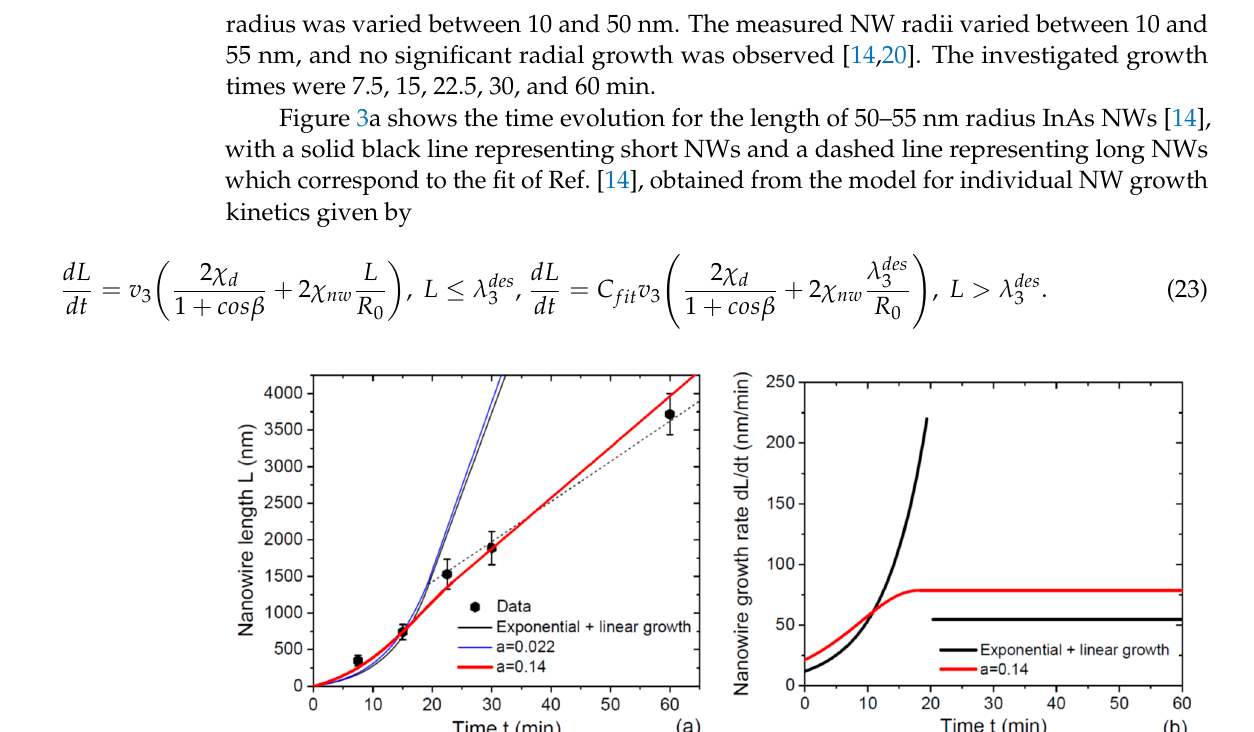
Figure 3. ( a ) Length of 50–55 nm radius Au ‐ catalyzed InAs NWs grown by MOCVD at 450 o C in 1000 nm pitch arrays versus time (symbols) [14], fitted by different models at a constant NW radius 𝑅 (cid:2868) (cid:3404) 52.5 nm (lines). Solid black line shows the fit by Equation (23) at 𝐶 (cid:3033)(cid:3036)(cid:3047) (cid:3404) 1, where the NW axial growth rate at 𝐿 (cid:3404) 𝜆 (cid:2871)(cid:3031)(cid:3032)(cid:3046) (cid:3404) 1450 nm is continuous. The dashed line is the fit of Ref. [14] at 𝐶 (cid:3033)(cid:3036)(cid:3047) (cid:3404) 0.247, with discontinuous NW growth rate at 𝐿 (cid:3404) 𝜆 (cid:2871)(cid:3031)(cid:3032)(cid:3046) . The blue line is the fit by Equations (8) and (11) at 𝜒 (cid:3031) (cid:4670)𝜒 (cid:3041)(cid:3050) (cid:4666)1 (cid:3397) 𝑐𝑜𝑠𝛽(cid:4667)(cid:4671)⁄ (cid:3404) 1.51, 2𝜒 (cid:3041)(cid:3050) 𝑣 (cid:2871) (cid:3404) 4.3, 𝜆 (cid:2871)(cid:3031)(cid:3032)(cid:3046) (cid:3404) 1400 nm, and 𝜒 (cid:3046) (cid:3404) 1 , corresponding to 𝑎 (cid:3404) 0.022 . The red line is the fit obtained from Equations (8) and (12) with 𝜒 (cid:3031) (cid:4670)𝜒 (cid:3041)(cid:3050) (cid:4666)1 (cid:3397) 𝑐𝑜𝑠𝛽(cid:4667)(cid:4671)⁄ (cid:3404) 3.15, 2𝜒 (cid:3041)(cid:3050) 𝑣 (cid:2871) (cid:3404) 3.7, and 𝜒 (cid:3046) (cid:3404) 0.143 (corresponding to 𝑐 (cid:3404) 0.124 and 𝑎 (cid:3404) 0.14 ), with continuous NW growth rate at 𝐿 (cid:3404) 𝐿 ∗ (cid:3404) 1020 nm. ( b ) Discontinuous NW growth rate was used line).